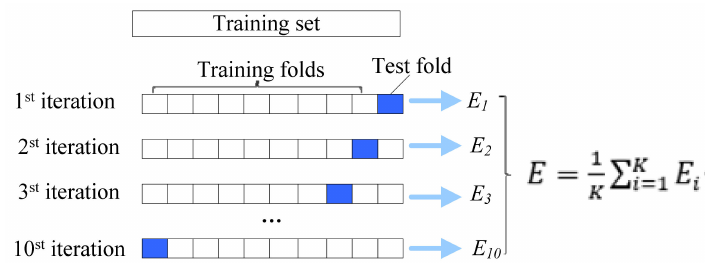
Figure 4. Ten-fold cross validation diagram. The dataset was divided into ten parts, and nine of them were taken as training data in turn, and one was used as test data for testing. The average value E of the ten-groups test results is calculated as an estimate of the model accuracy and is used as a performance indicator for the current K-fold cross-validation model. Where E i represents the cross-validation error of the i th group.3.4. The RFAmyloid Online Prediction